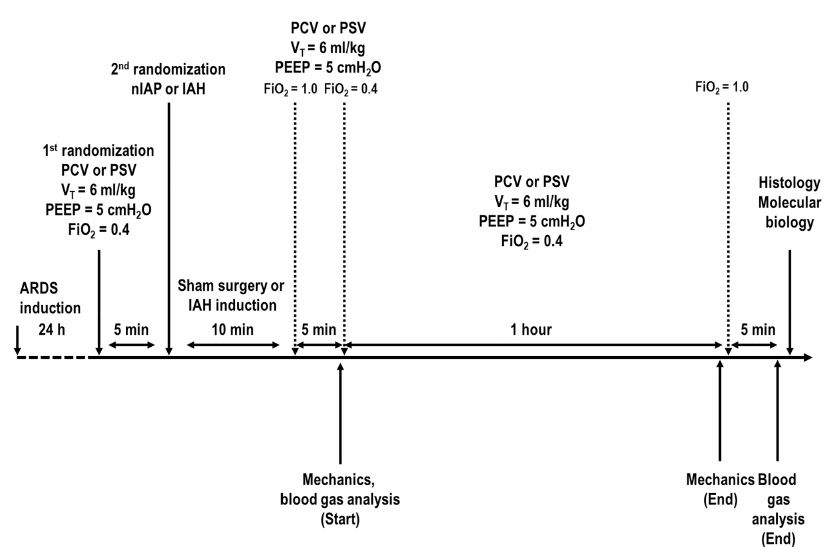
Fig 1. Timeline representation of the experimental protocol. First randomization: pressure-controlled ventilation (PCV) or pressure support ventilation(PSV). Second randomization: intra-abdominal hypertension (IAH) or normalintra-abdominal pressure(nIAP). Start: immediately after surgery (Sham) or IAH inductionat PCV or PSV. V T , tidal volume; PEEP, positive-end expiratory pressure; FiO 2 , fraction of inspiredoxygen. Mechanics and arterial blood gases were evaluatedat Start and End (after 1 h of mechanical ventilation in PCV or PSV).